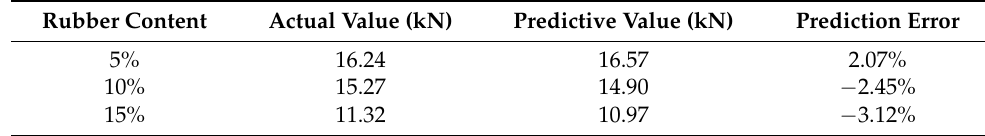
Table 8. Amplitude (5) single-parameter neural network prediction results.